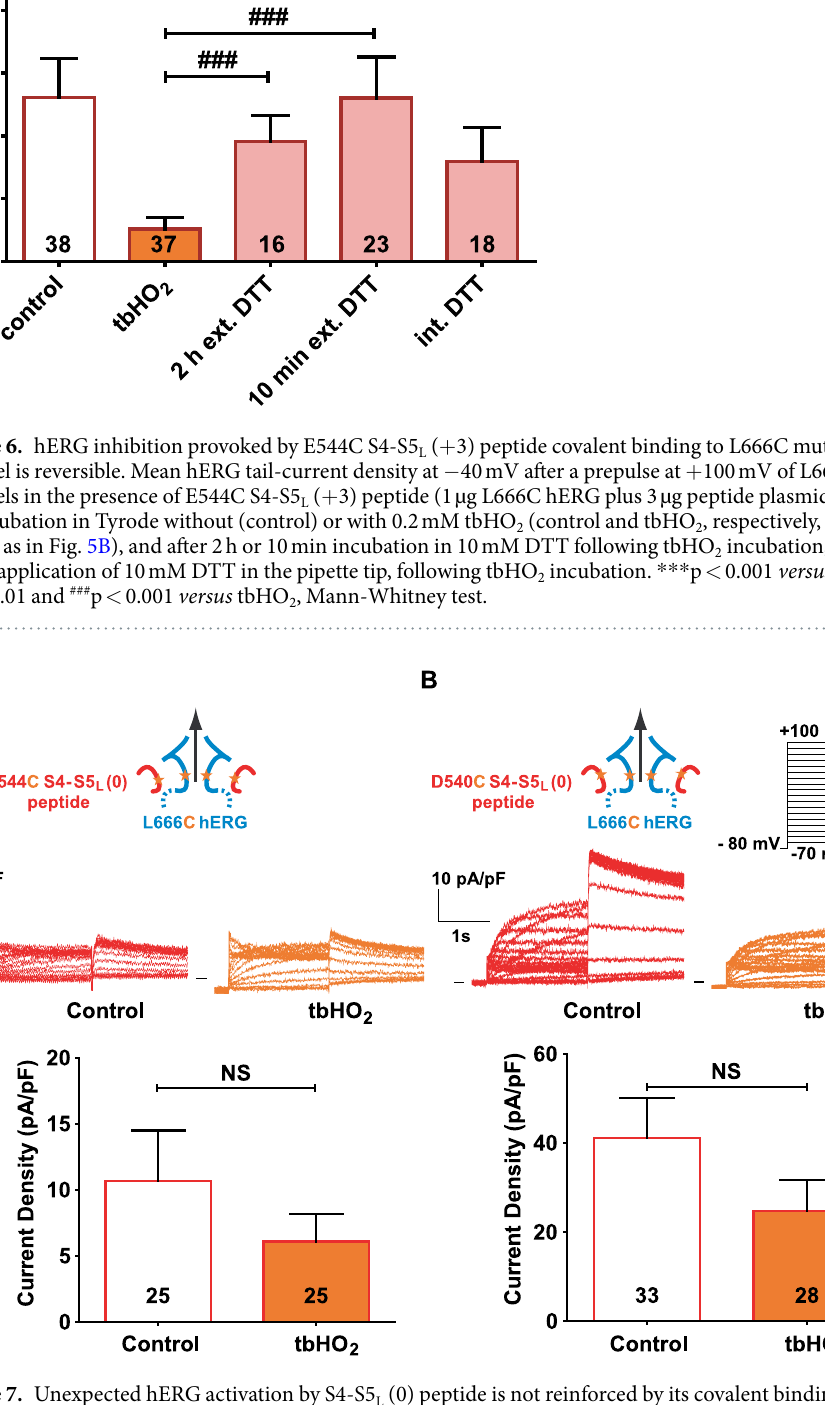
Figure 7. Unexpected hERG activation by S4-S5 L (0) peptide is not reinforced by its covalent binding though a disulfide bond. ( A ) Top, representative, superimposed recordings of the L666C hERG current in the presence of E544C S4-S5 L (0) peptide (1 µ g L666C hERG plus 3 µ g peptide plasmids) after 2 h incubation in Tyrode without (control) or with 0.2 mM tbHO 2 (tbHO 2 ), using the protocol shown in ( B ). Bottom, corresponding mean hERG tail-current density at − 40 mV after a prepulse at + 100 mV. ( B ) D540C S4-S5 L (0) peptide same as in